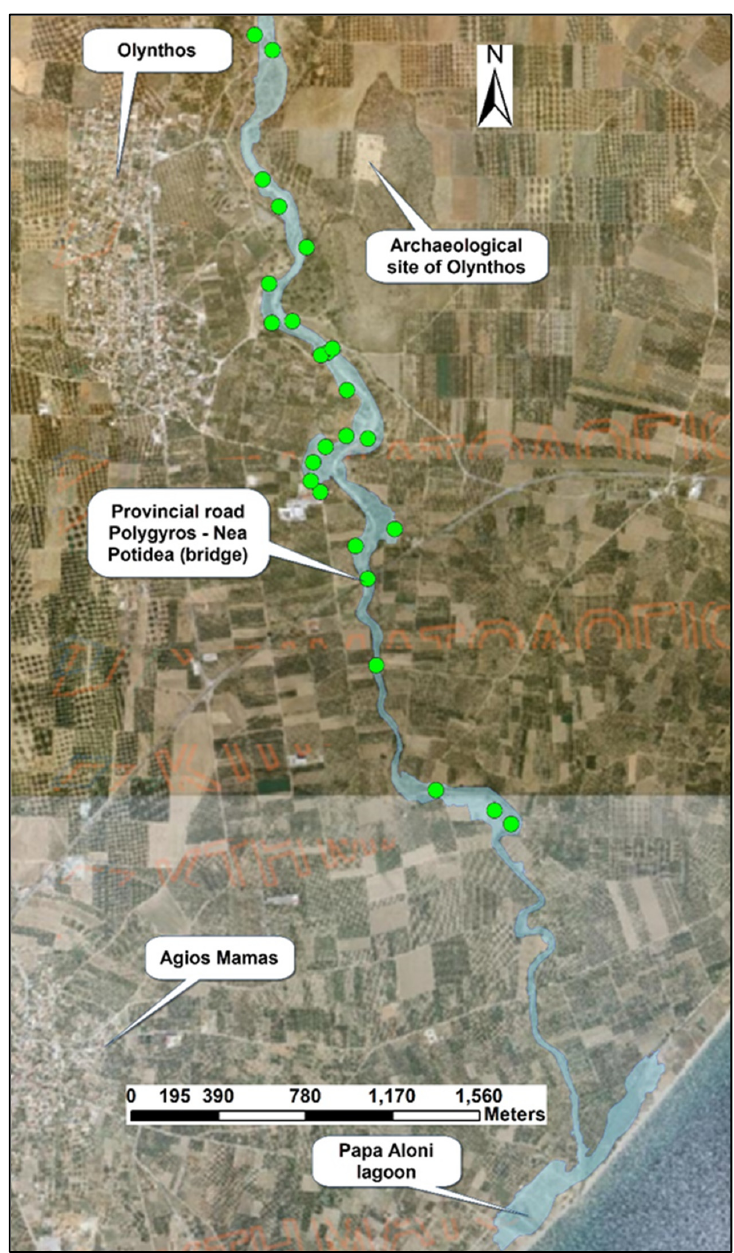
Figure 9. Post-flood points and observed flood extent (blue area) at the Stavros floodplain.